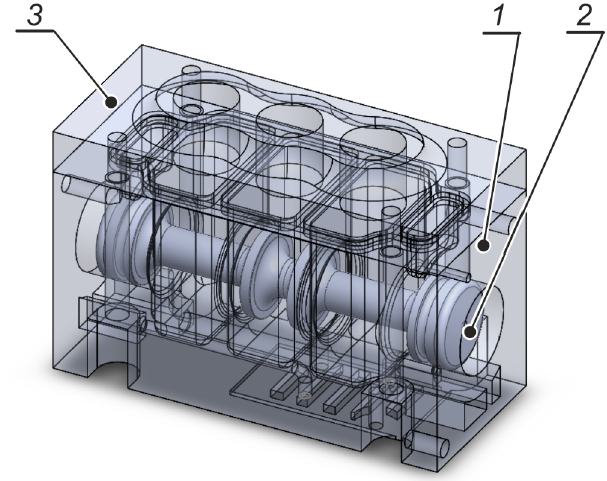
Figure 3. Solid model of the valve.